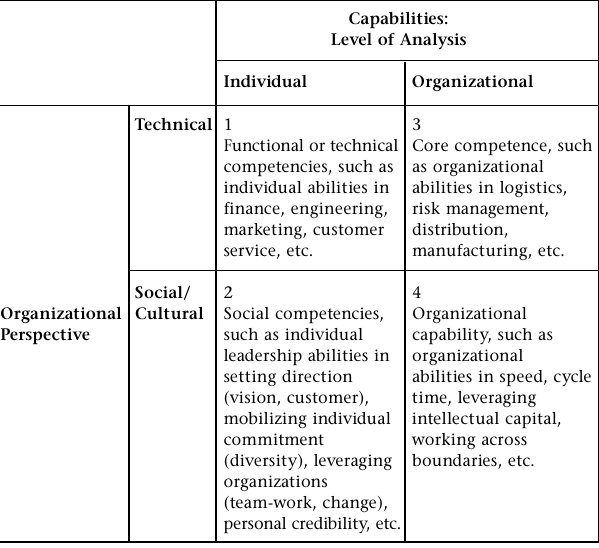
Figure 1: Competence and capability (Ulrich, 1998) Figure 1 illustrates how individual and organisational capabilities can be regarded from a technical as well as a social perspective. The technical approach emphasises functional orientation, whilst the social dimension requires coping with how individuals and groups connect and